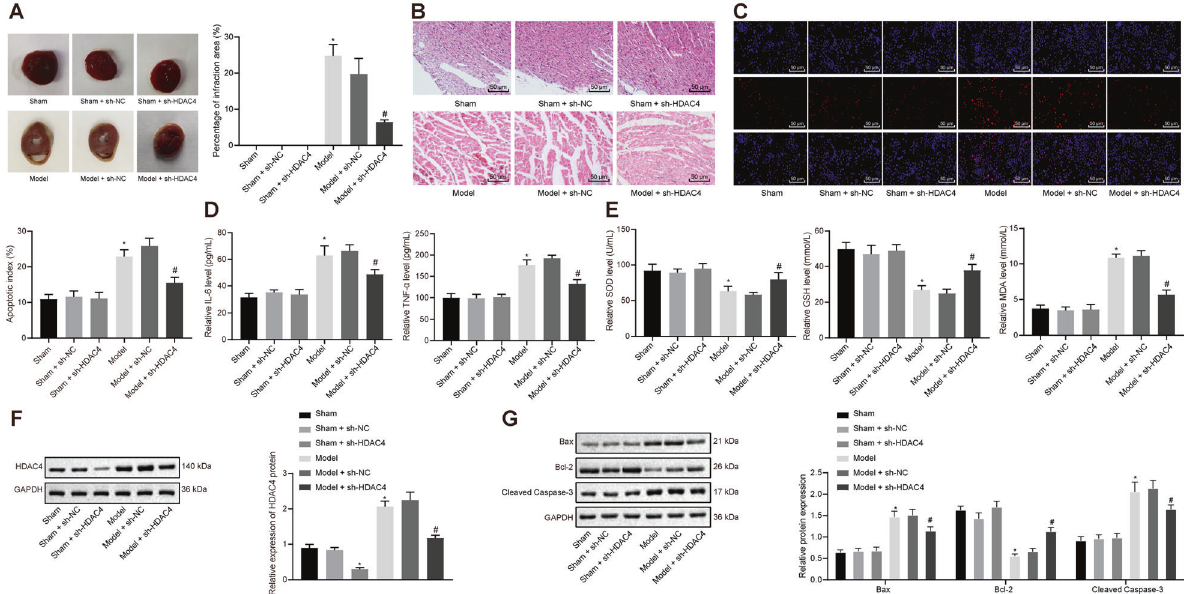
Fig. 1 HDAC4 is up-regulated in rat myocardial tissues after MIRI and its silencing alleviates myocardial injury in vivo. A Analysis of the myocardial injury area of rats by TTC staining ( n = 5 for rat in each group). B Representative images of the myocardial injuries evaluated by H&E staining ( n = 10; scale bar = 50 μ m). C Apoptosis of cardiomyocytes detected by TUNEL assay ( n = 10; scale bar = 50 μ m). D Serum levels of IL-6 and TNF- α in peripheral blood of rats measured by ELISA ( n = 10). E Determination of SOD, GSH, and MDA contents in rat myocardial tissues ( n = 10). F Protein expression of HDAC4 in rat myocardial tissues detected by western blot analysis, normalized to GAPDH ( n = 10). G Protein expression of Bax, Bcl-2, and cleaved Caspase-3 in rat myocardial tissues detected by western blot analysis, normalized to GAPDH ( n = 10). * p < 0.05 vs. the sham-operated rats; # p < 0.05 vs. the rats with MIRI. Data were all measurement data and expressed as mean ± standard derivation. Comparisons among multiple groups were analyzed by one-way ANOVA, followed by Tukey ’ s post hoc